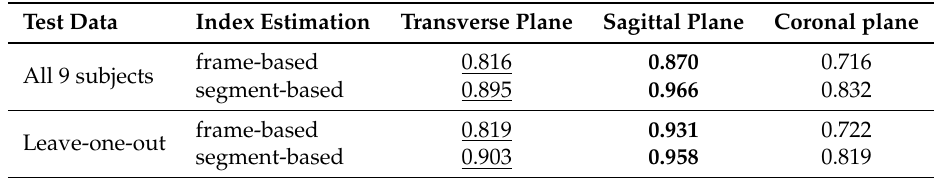
Table 1. AUCs obtained from experiments considering the whole body. The first and second highest results are emphasized in bold and underlined, respectively.